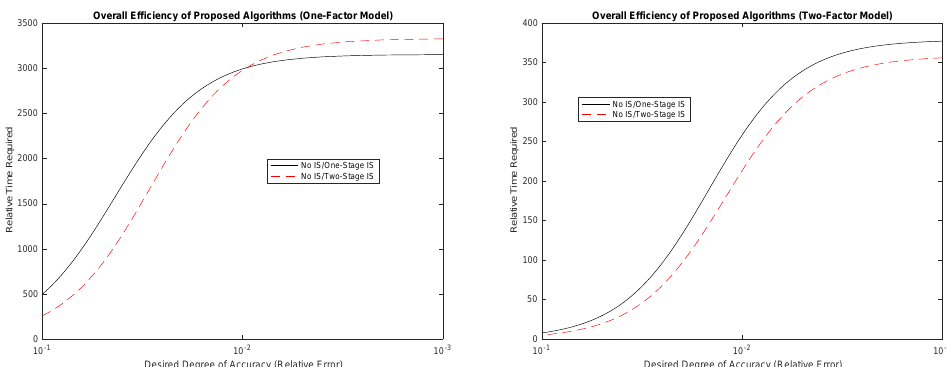
Figure 8. This figure illustrates the overall efficiency of the proposed algorithms. Specifically, the solid [dashed] line in the left panel illustrates the ratio of (i) the total run time (in seconds) required to ensure that the standard estimate’s relative error does not exceed a given threshold to (ii) the run time required by the one-stage [two-stage] algorithm, in the one-factor model. The right panel corresponds to the two-factor model. Parameter values are the same as in Figure 7 and Table